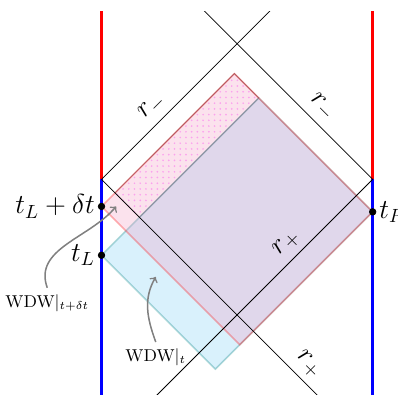
Figure 2 . Two nearby Wheeler-de Witt patches for BTZ black hole at t and t + (cid:14)t and the part that contributes to the late time behavior of complexity growth.This (cid:12)gure is drown from (cid:12)gure 4 of